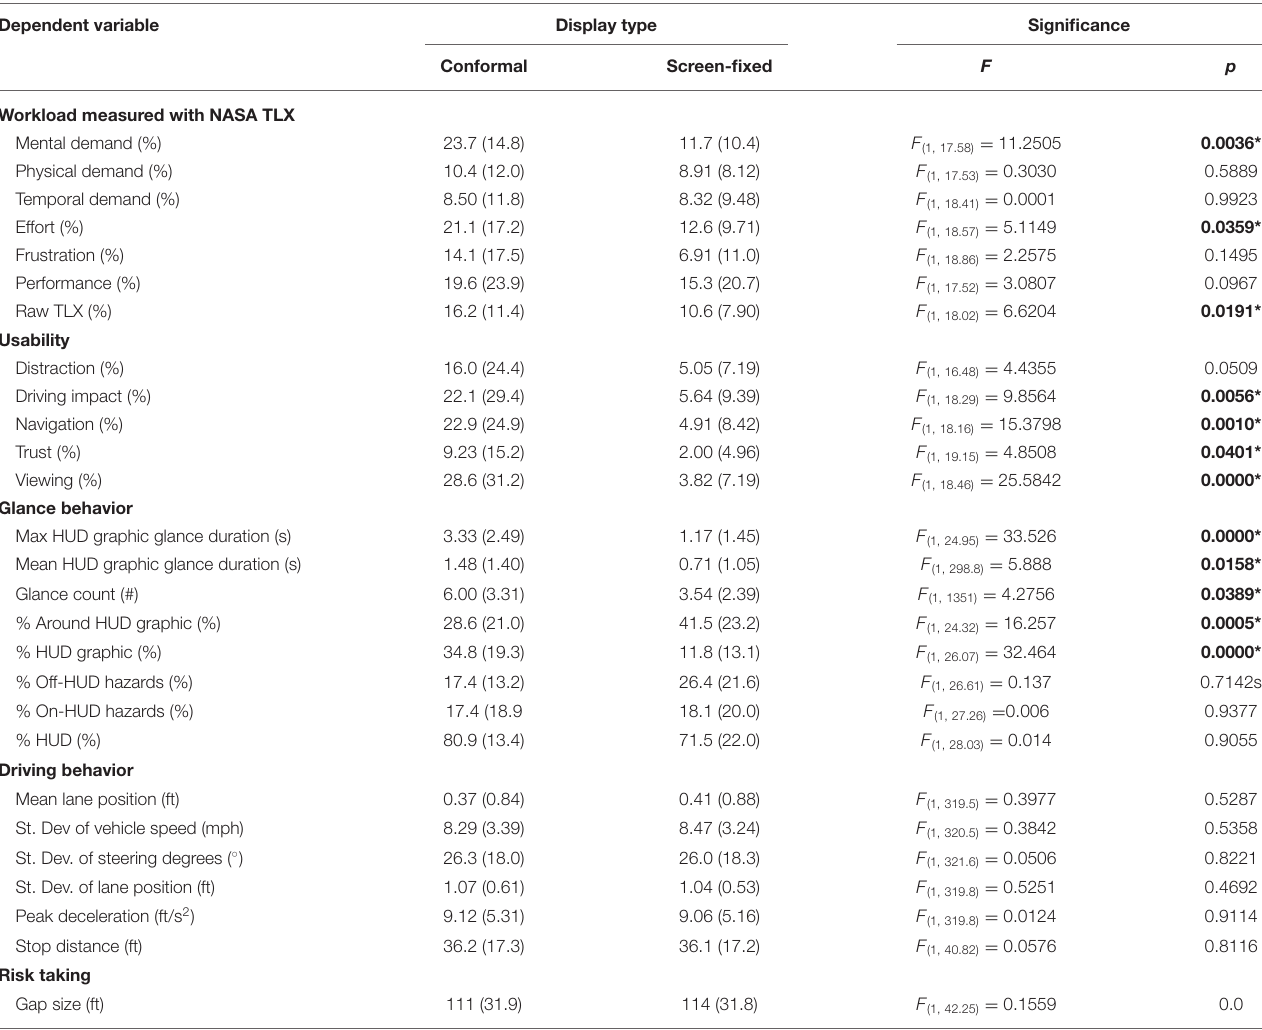
TABLE 1 | Means, standard deviations (between parentheses), and F- and p -values for the repeated measures ANOVA. Dependent